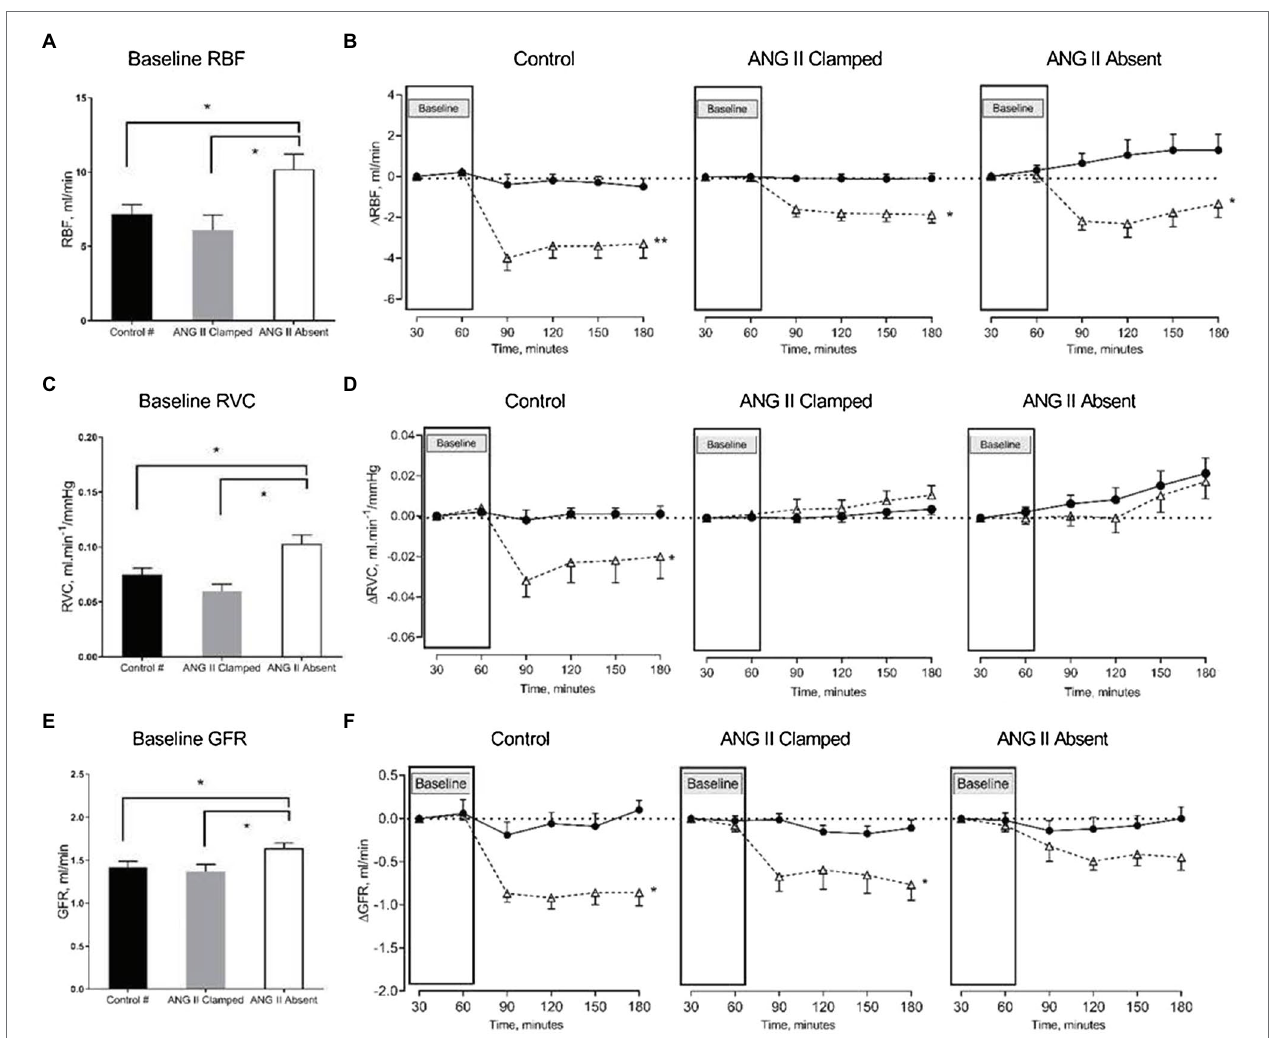
FIGURE 3 | Changes in renal blood flow (RBF), renal vascular conductance (RVC), and glomerular filtration rate (GFR) in response to increased RVP. The bar graphs show the baseline RBF (A) , RVC (B) , and GFR (C) in untreated control (black, control, n = 8), ANG II Clamp (gray, ANG II Clamp, n = 10) and ANG II Absent (open bar, ANG II Absent, n = 8, BP supported by AVP) rats. The line charts show changes from baseline, △ RBF (B) , △ RVC (D) , and △ GFR (F) . In the line chart, the first two time points in each line represent baseline. The latter four time points show control ( ● , control) and major RVP elevation ( △ , RVP20). Baseline RBF was significantly higher in the ANG II Absent group than in untreated control and ANG II Clamp group ( A ; * p < 0.05). Elevation of RVP reduced RBF in untreated control group ( B ; ** p < 0.001), in ANG II Clamp and ANG II Absent groups ( B ; * p < 0.05). Baseline RVC was higher in ANG II Absent group ( C ; * p < 0.05). Increased RVP reduced RVC in untreated control group ( D ; * p < 0.05), but did not impact RVC in either ANG II Clamp or ANG II Absent group. Baseline GFR was higher in the ANG II Absent group than in the other groups ( E ; * p < 0.05). Increased RVP caused significant reduction of GFR in both untreated and ANG II Clamp rats ( F ; * p < 0.05), while the apparent decrease in ANG II Absent rats was not statistically significant ( p = 0.081). # Data from these were published in Huang et al.